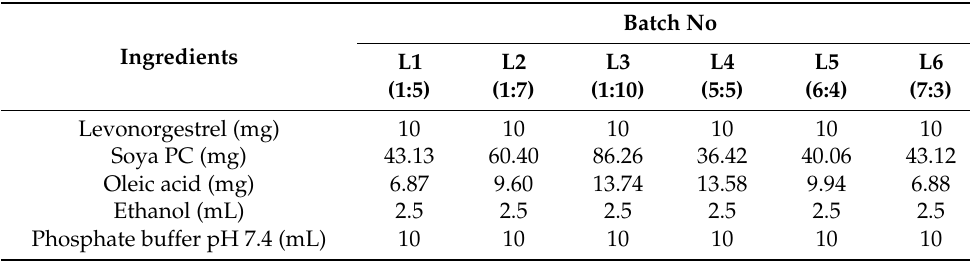
Table 1. Composition of liposome